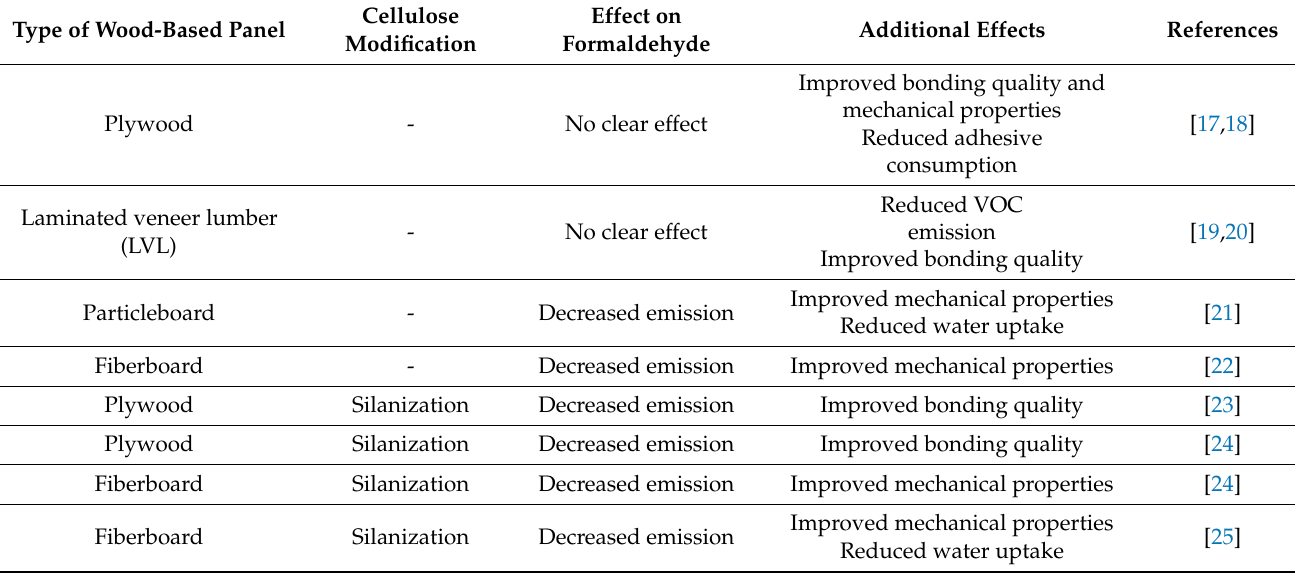
Table 1. Examples of studies concerning UF resin modification with cellulosic